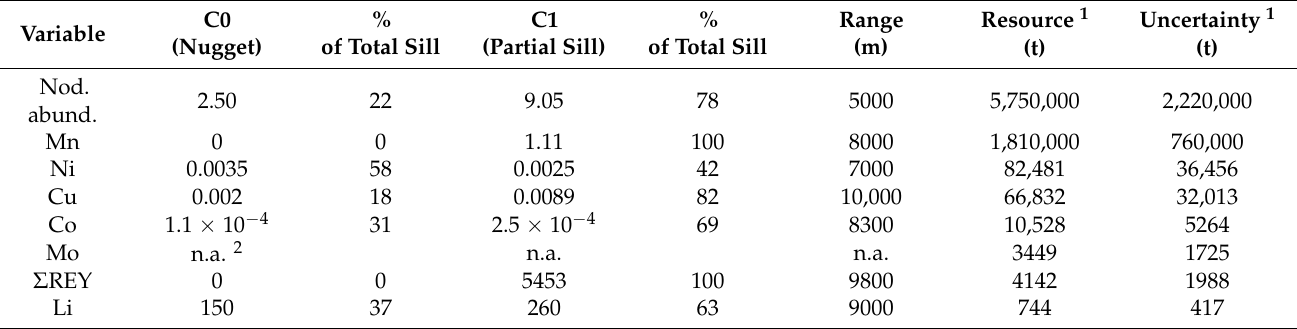
Table 9. Variogram models of PA1-East (461 km 2 ).